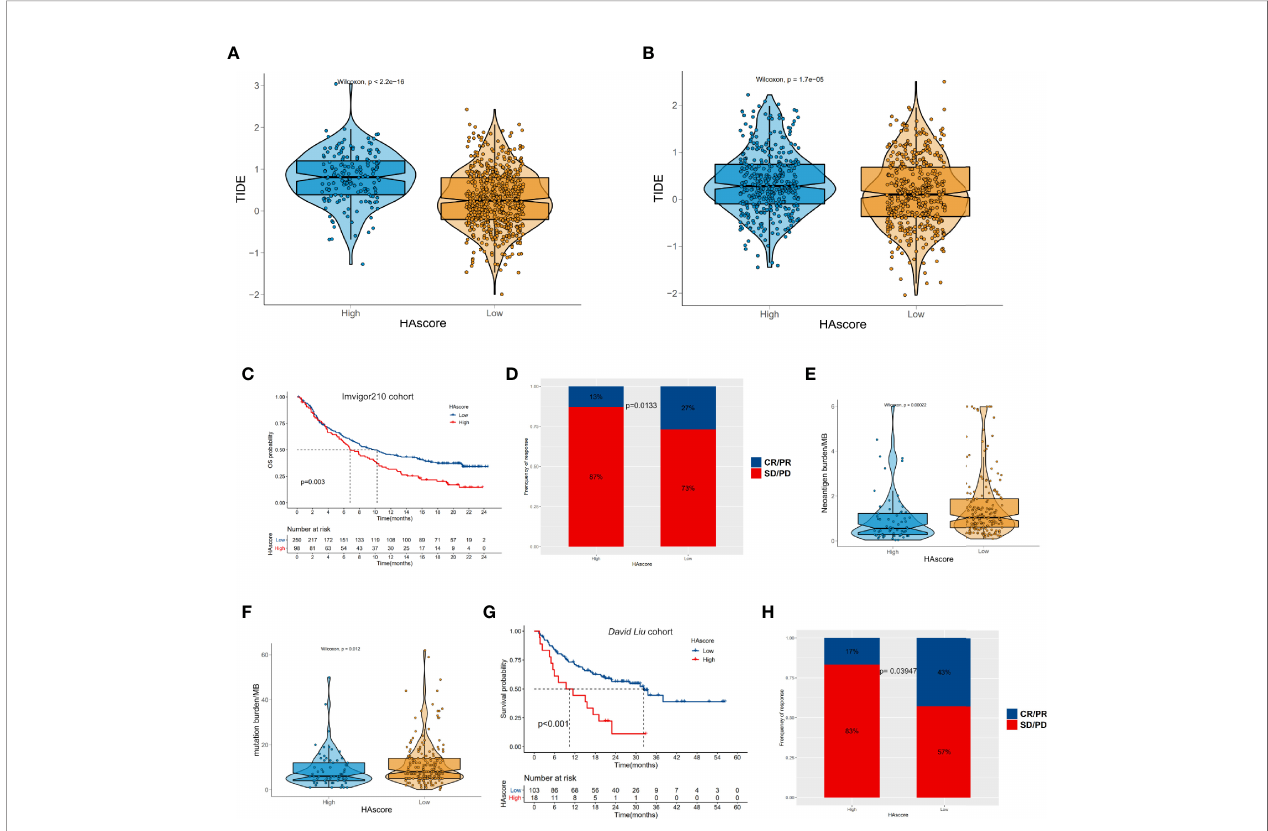
FIGURE 7 | The relationship between HAscore and immunotherapy. (A, B) The TIDE scores of individual HCC samples in the high HAscore or the low HAscore groups. (A) shows the result from the RNA-seq meta cohort and (B) shows the result from the GEO meta cohort. (C, G) Kaplan – Meier curves show the overall survival time in the high HAscore or the low HAscore groups after the treatment of PD-L1 pathway blockgade immunotherapy (C) or PD-1 pathway blockade immunotherapy (G) . (D, H) The proportion of patients with different responses to PD-L1 blockage (D) or PD-1 blockage (H) . (E, F) the differences of neoantigen burden (E) or mutation burden (F) in the high HAscore or the low HAscore